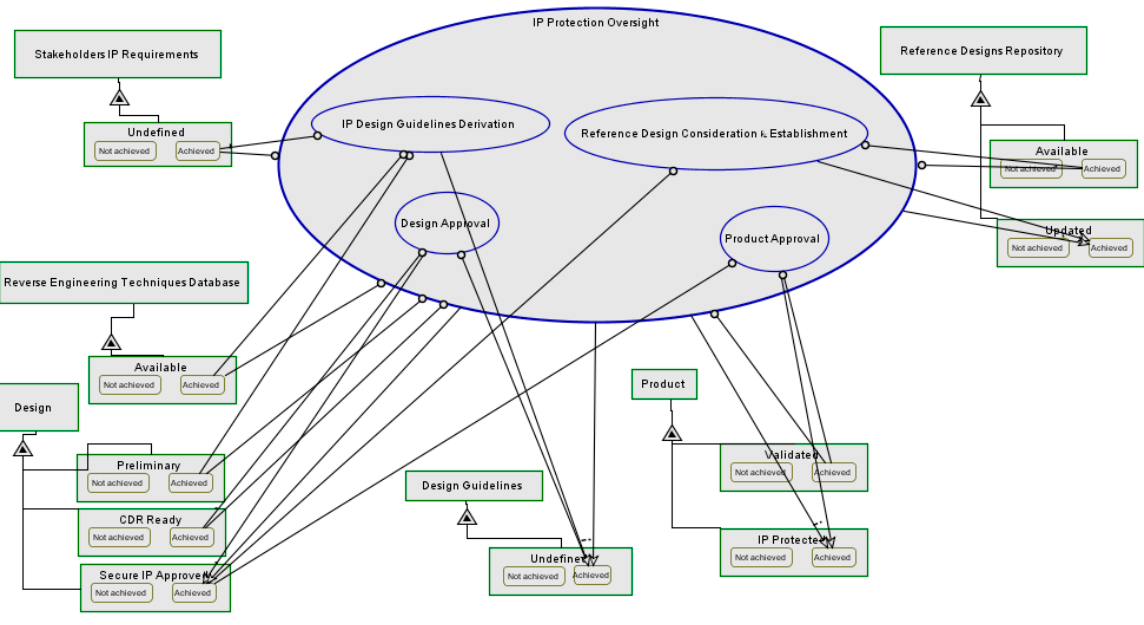
Figure 14. OPM diagram of the IP Protection Oversight case study.